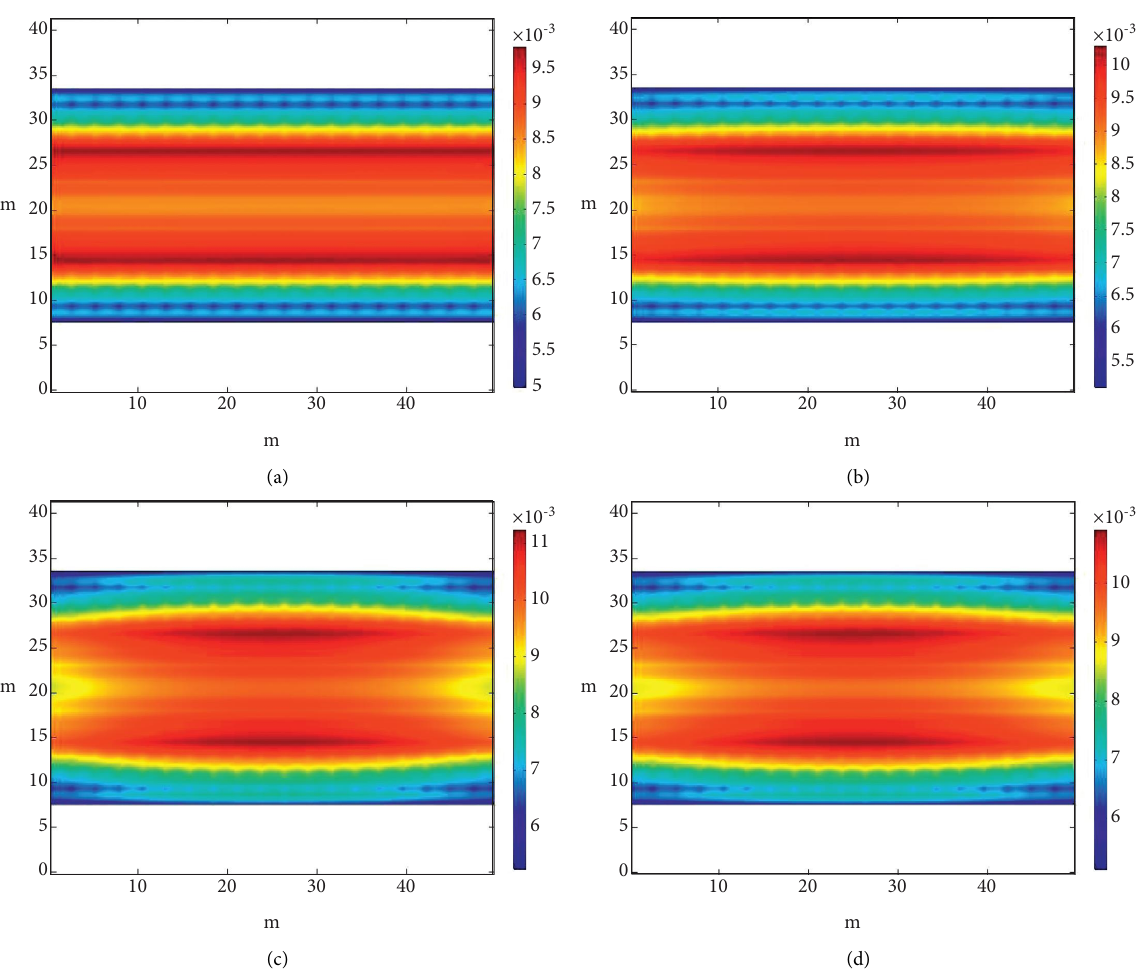
Figure 10: Shaded view of the upper surface settlement of the unreinforced embankment: (a) d � 1; (b) d � 3; (c) d � 5; (d) d �